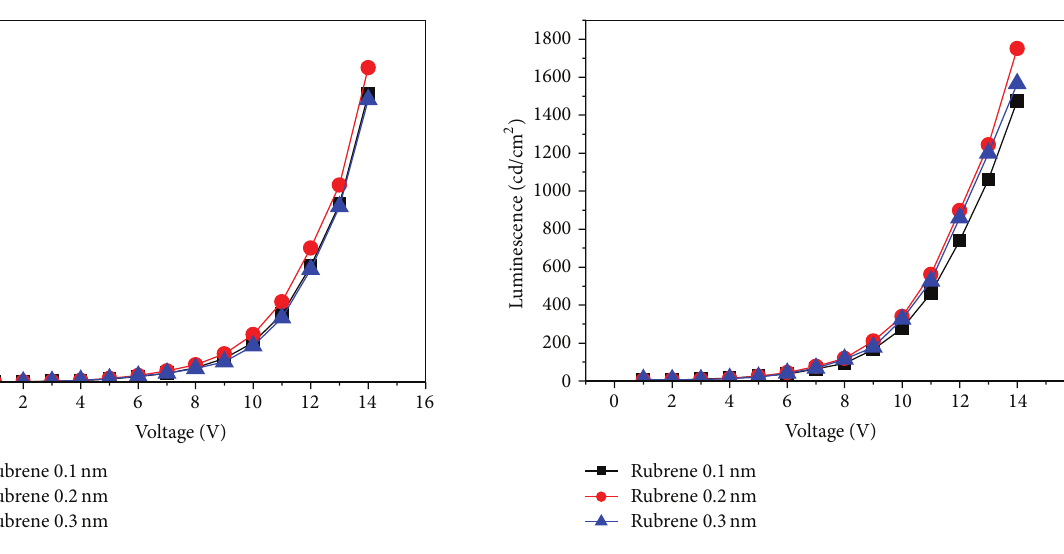
Figure 2: The current density-voltage (J-V) characteristics of the devices with various thicknesses of Rubrene layer.